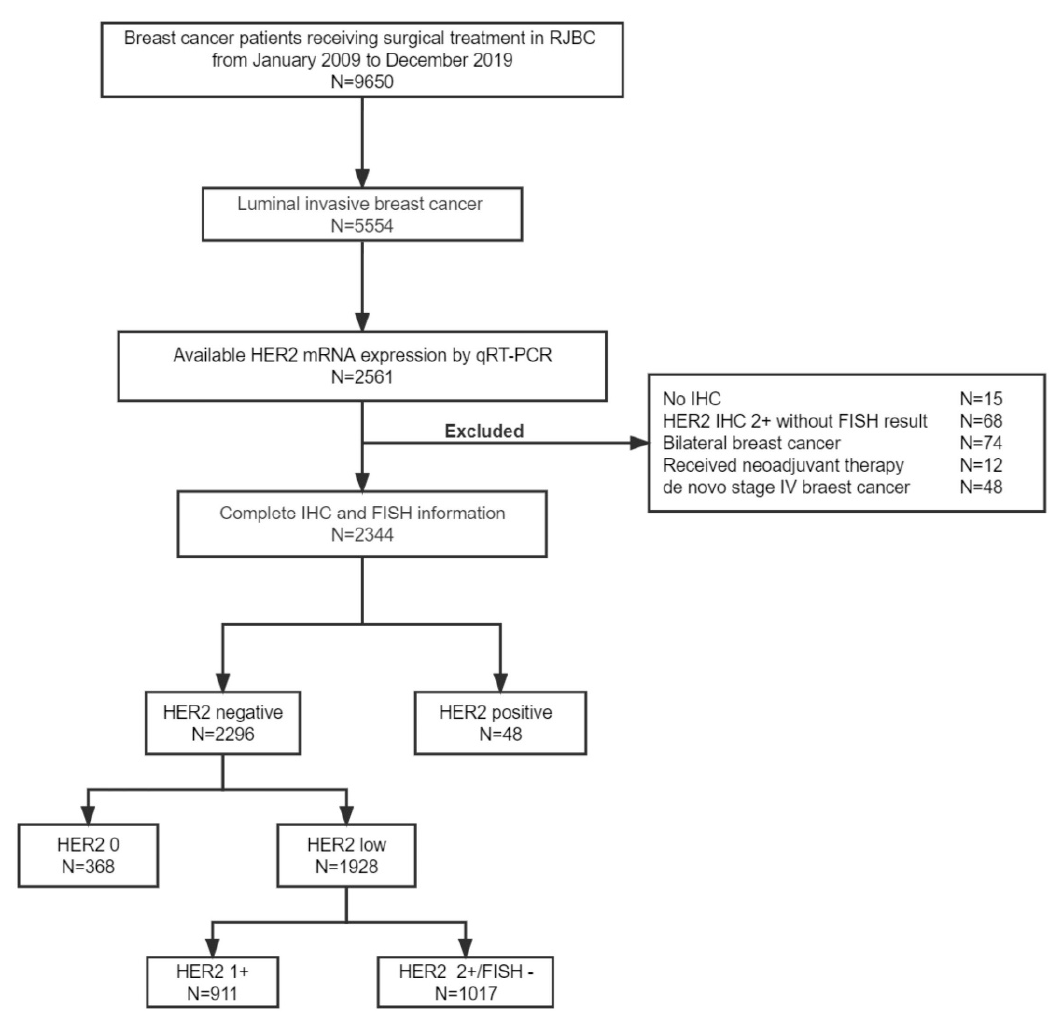
Figure 1. Study flowchart. Abbreviations: HER2, human epidermal growth factor receptor 2; mRNA, message ribonucleic acid; qRT-PCR, quantitative reverse transcriptase-polymerase chain reaction; IHC, immunohistochemistry; FISH, fluorescence in situ hybridization. Table 1. Baseline patient characteristics by HER2 IHC/FISH